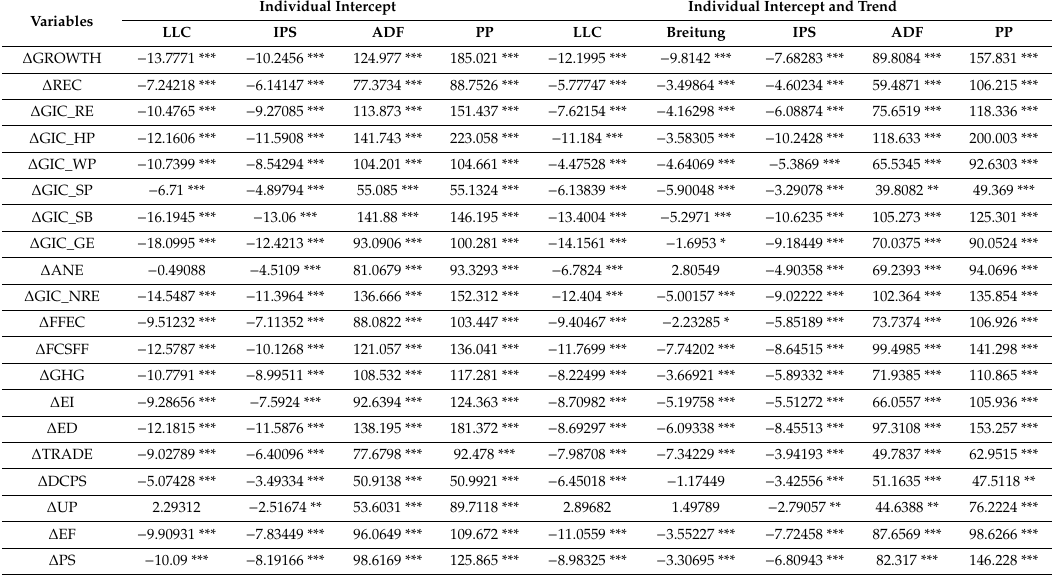
Table 10. Results of the panel unit-root: variables in first di ff